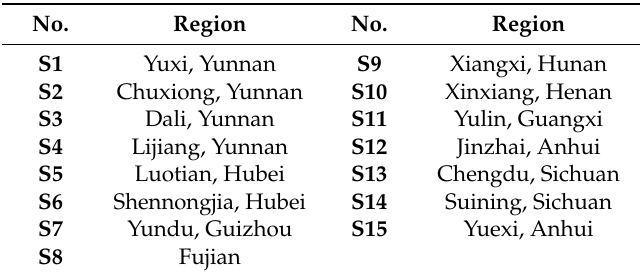
Table 4. The regions of origin of the 15 samples.